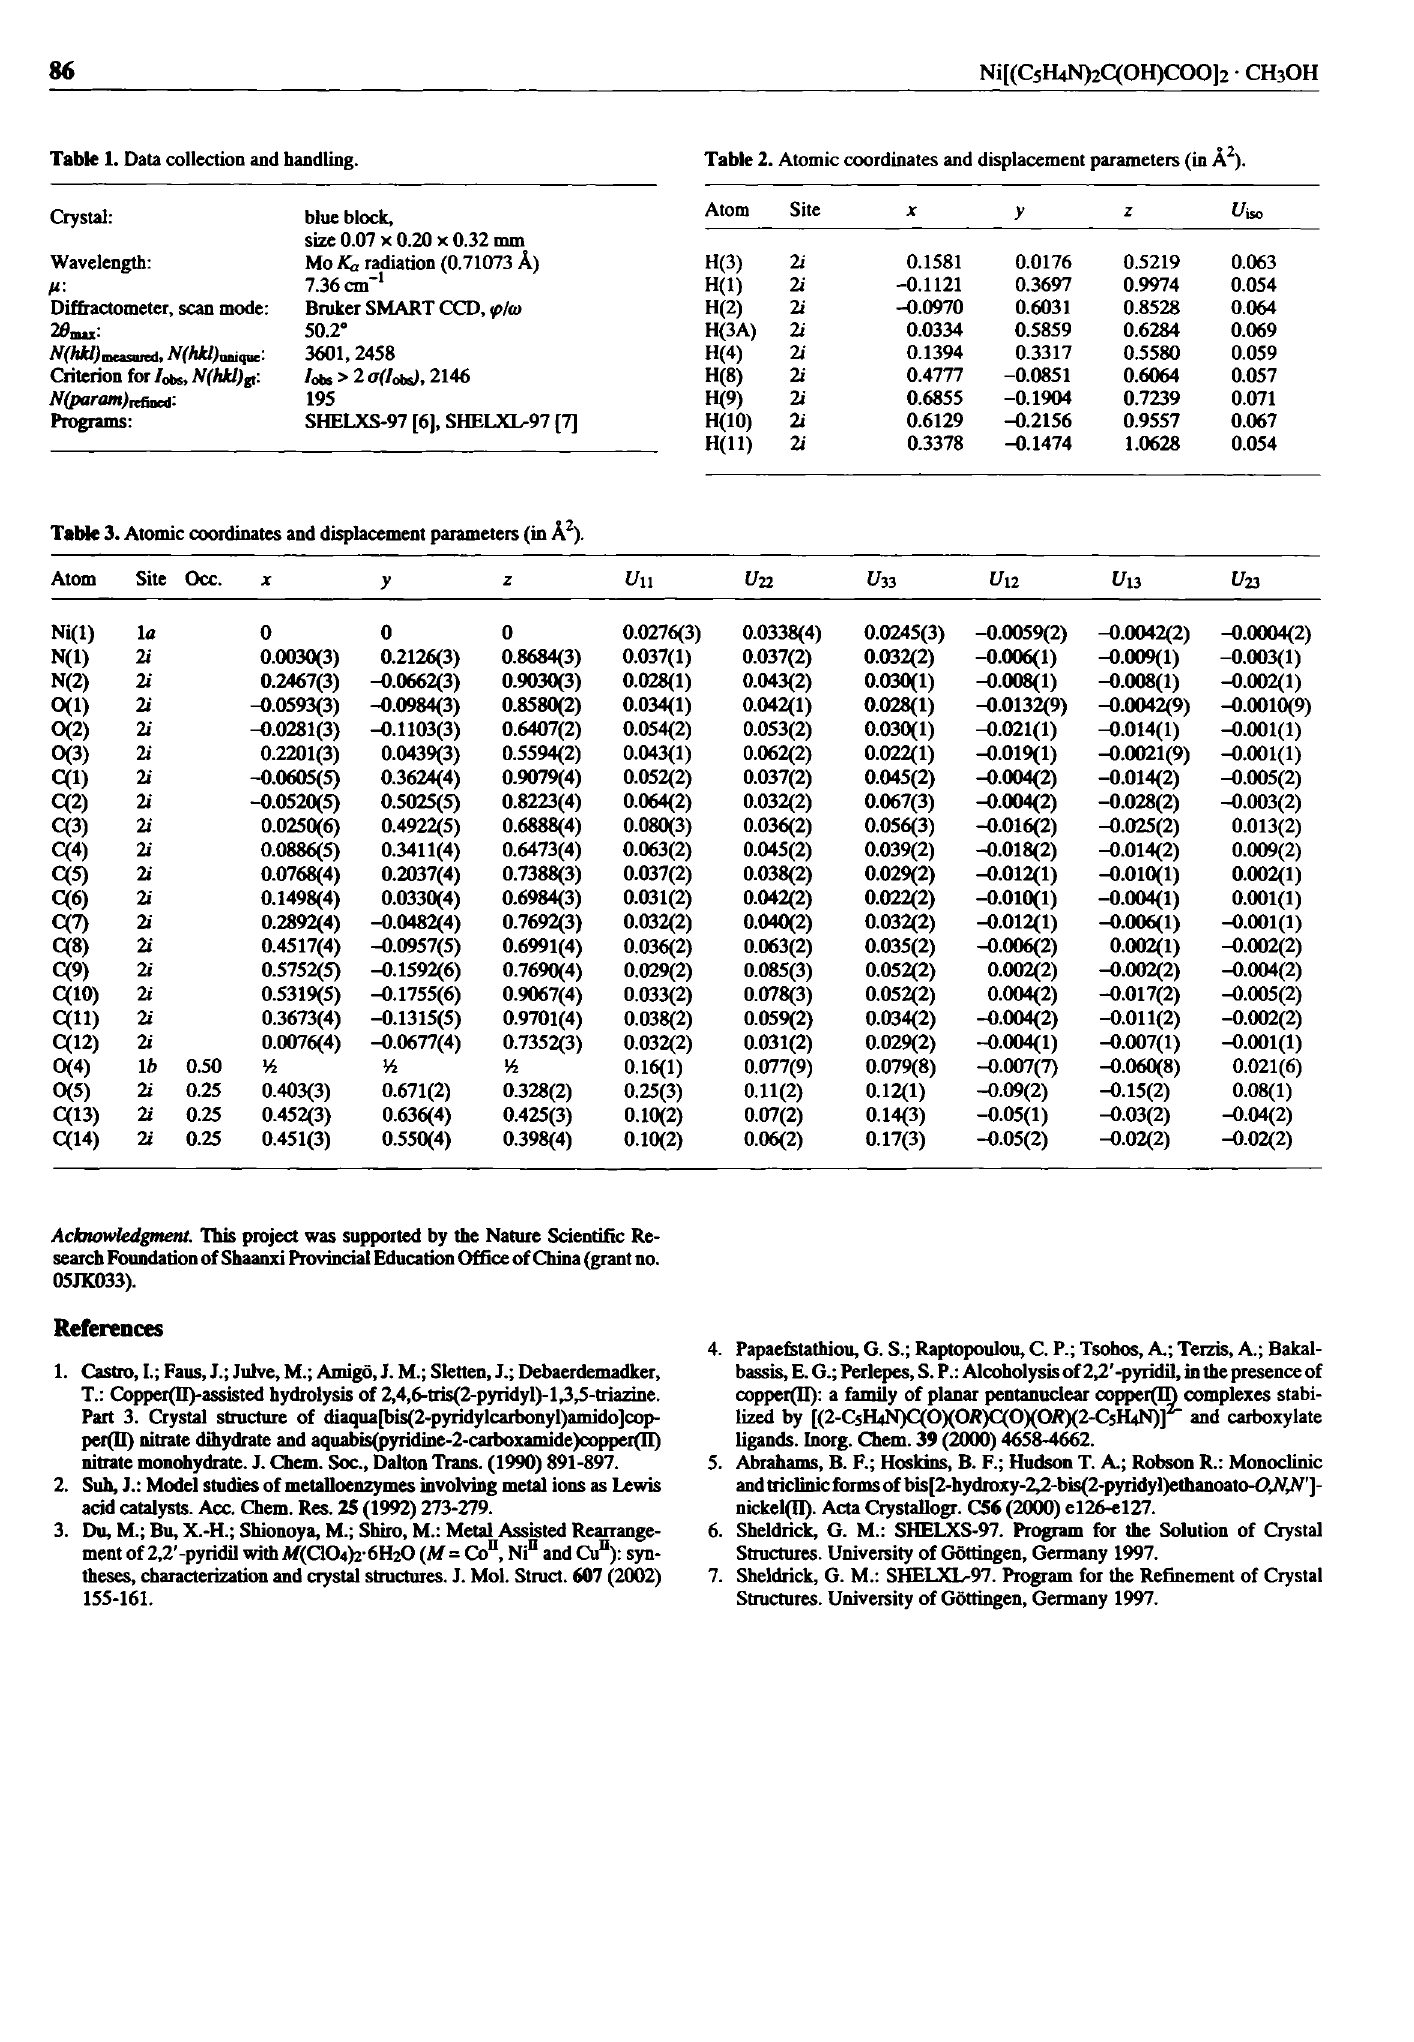
Table 1. Data collection and handling. Table 2. Atomic coordinates and displacement parameters (in A 2 ).